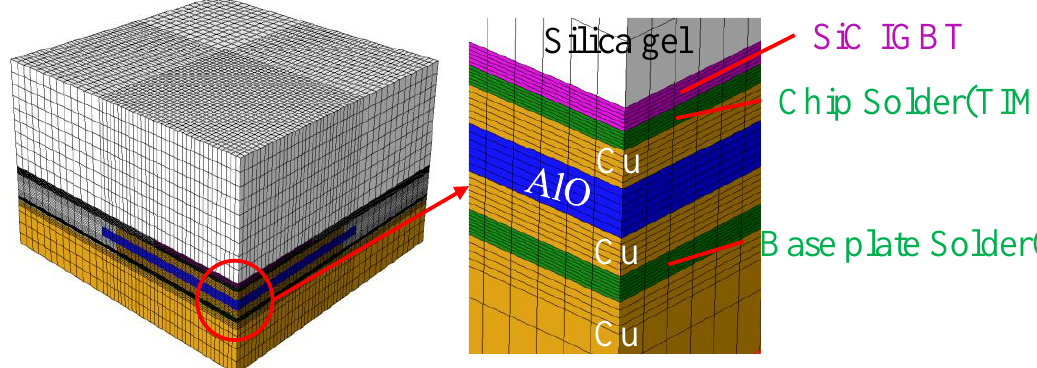
Figure 3: The 1/4 FE